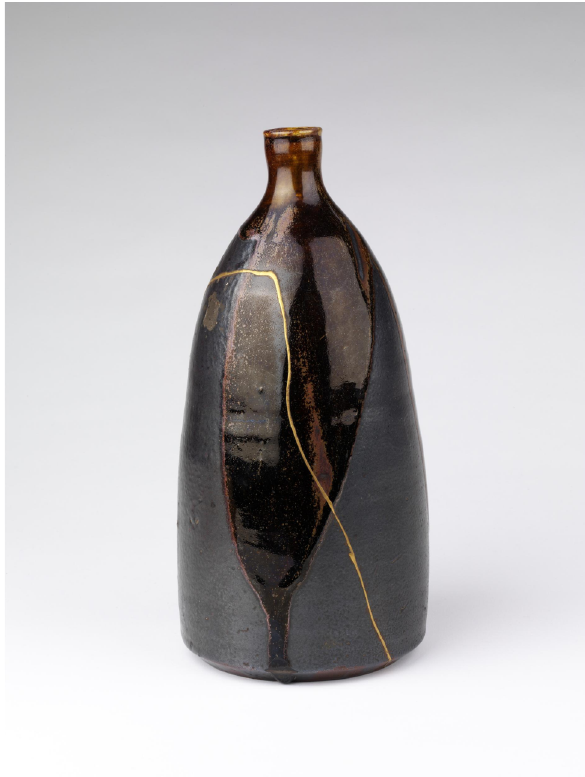
Figure 4 | Bottle covered in overlapping dark brown glazes; large break extending around the body repaired with gold lacquer. Takatori, Japan. 1700-1800. Courtesy of © Victoria and Albert Museum, London.